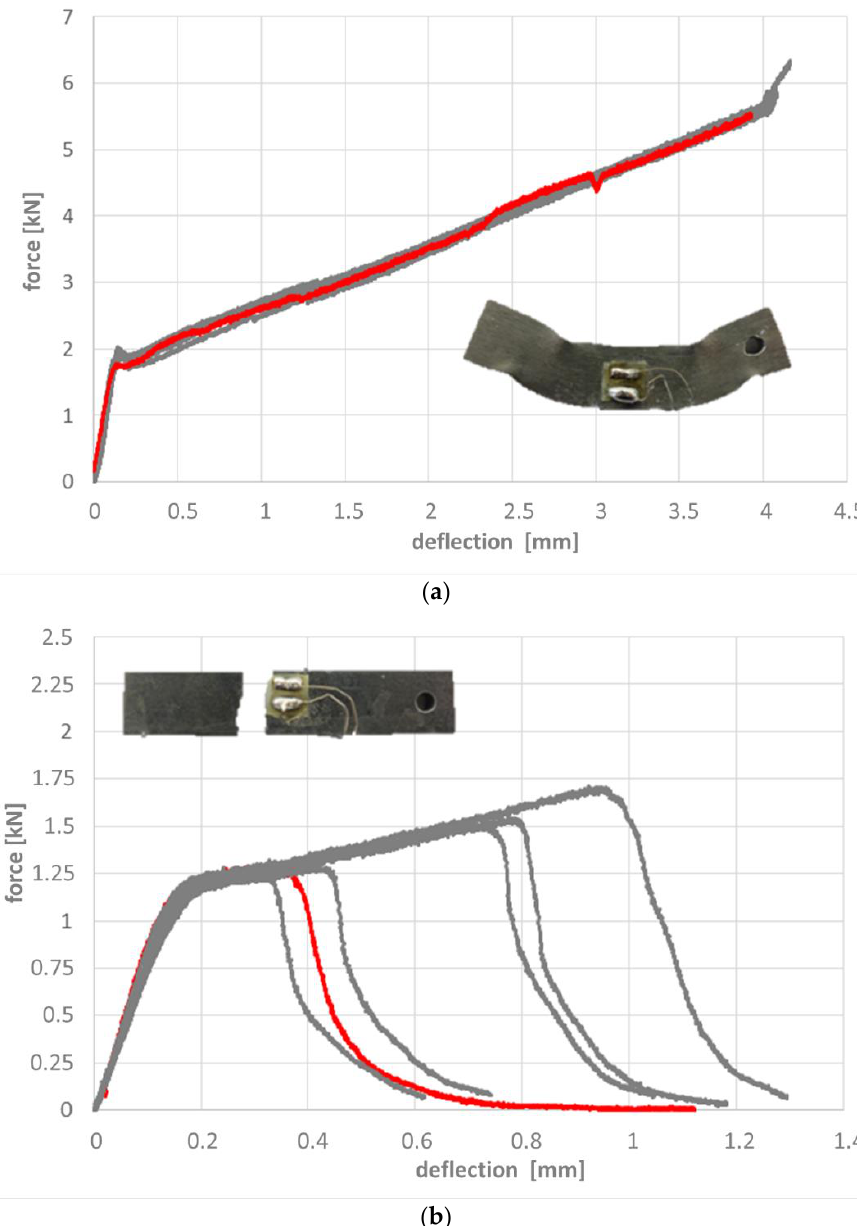
Figure 11. Force-deflection curve for samples without heat treatment, ( a ) without, ( b ) with hollow glass microspheres. Inserts show the samples corresponding to the red curve. Note the difference in scale of both axes.